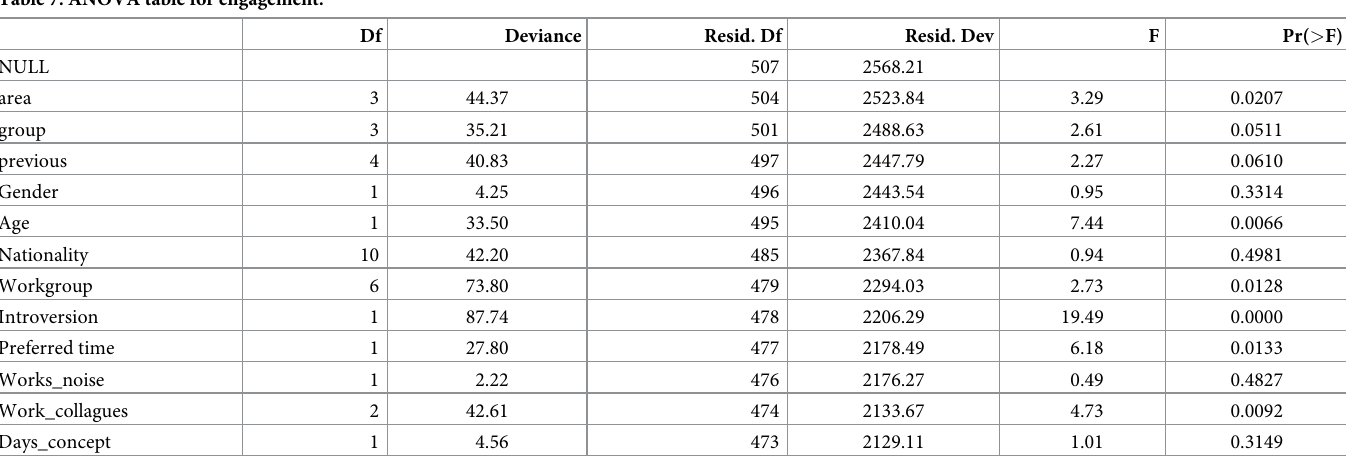
Table 7. ANOVA table for